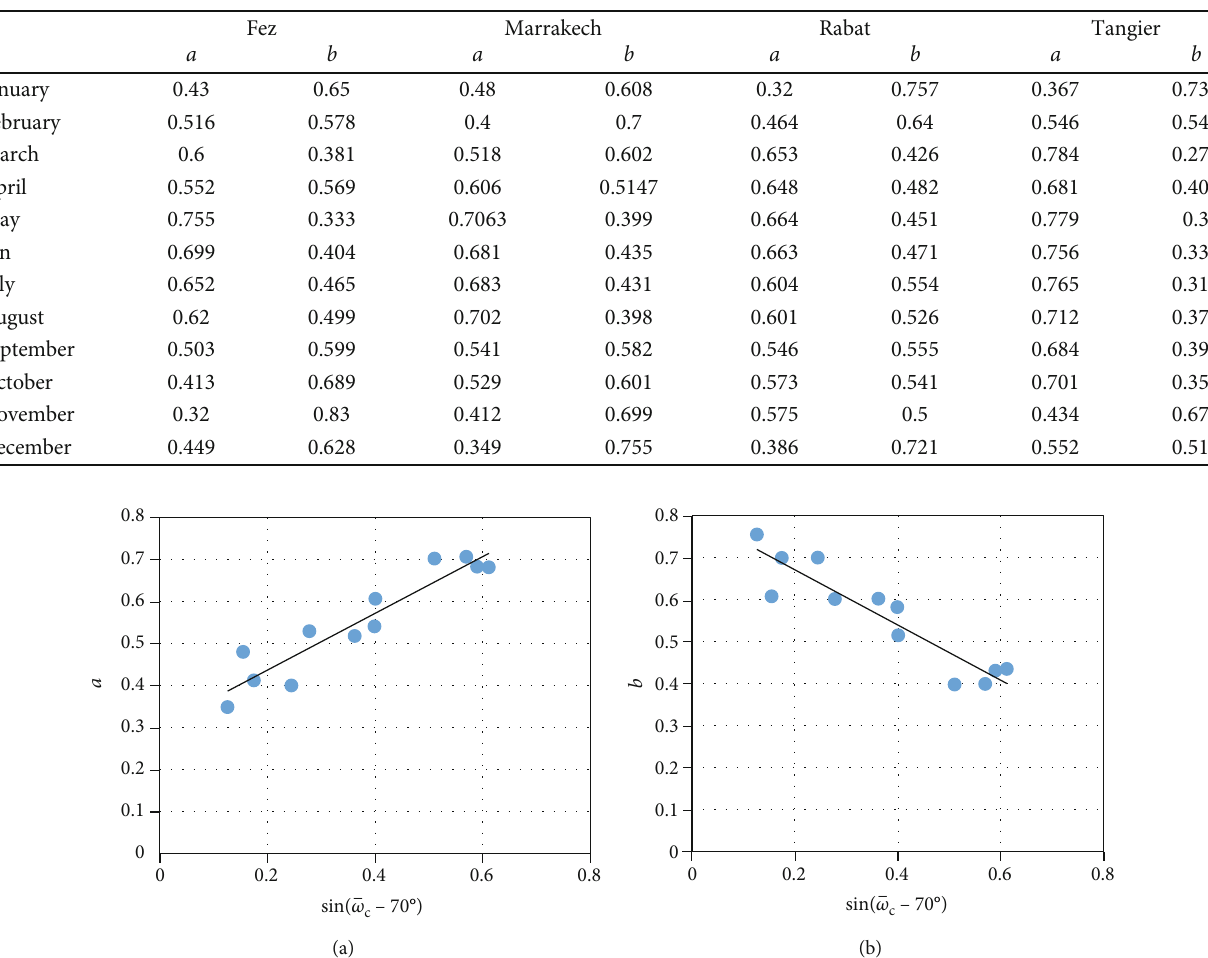
Table 4: The a and b values calculated for the representative station ’ s measurements.